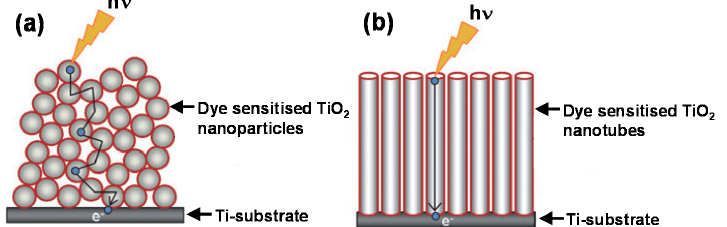
Figure 1. Schematic diagrams of electron transport pathway in ( a ) TiO 2 nanoparticulate (NP)-based photoanodes; and ( b ) TiO 2 nanotube (NT)-based photoanodes. Reprinted with permission from [19]. Copyright 2009 Royal Chemical Society.